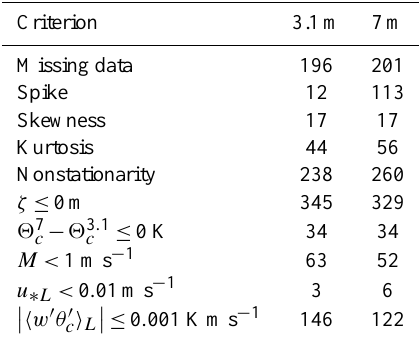
Table 2. Summary statistics of normalized flux